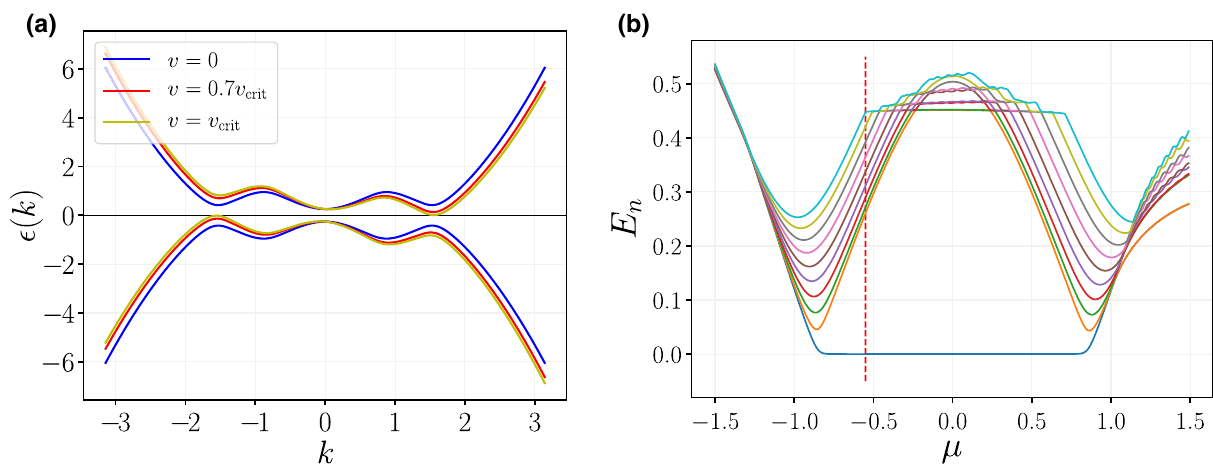
FIG. 12. (a) Energy dispersion of the Hamiltonian, Eq. (F4), in the moving frame for three different velocities. The velocity tilts the dispersion and the gap closes when v = v crit . The model parameters used for this dispersion are B = α = 1.0, (cid:3) = 0.5 and μ = − 0.55, V = 0.0. (b) Excitation energy eigenvalues E n of the NW model on a lattice for open-boundary conditions as a function of the chemical potential μ . The red dashed line indicates μ = − 0.55. The other parameters are the same as for (a). We get a zero mode (blue line) but also some Andreev bound states (e.g., orange line) that come down when we bring μ closer to the bottom of the band.